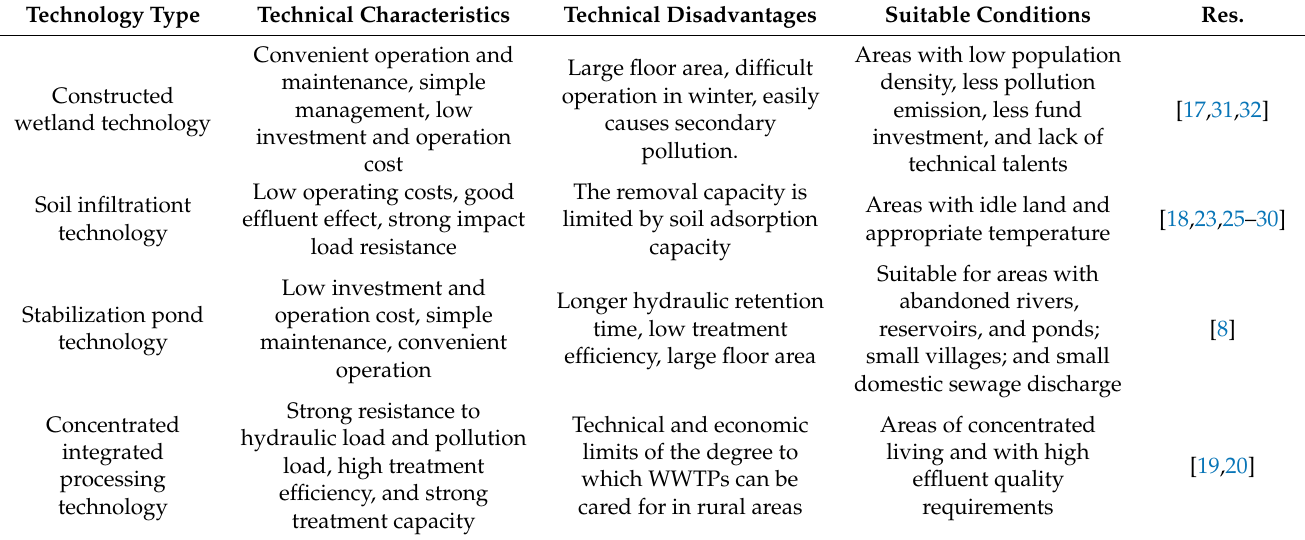
Table 1. Comparison of rural domestic sewage treatment